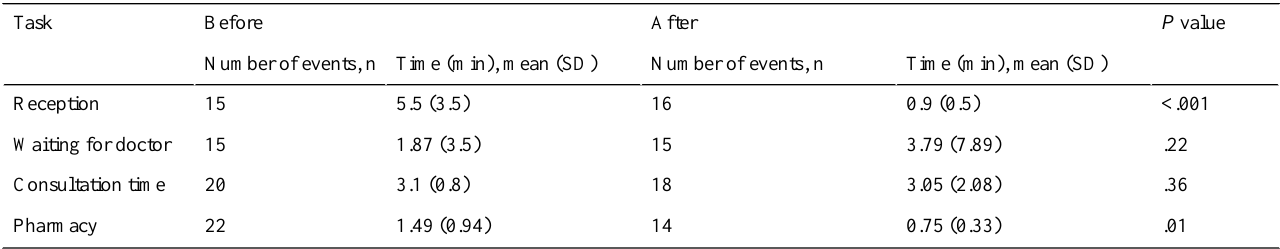
Table 3. The time spent per task at baseline and 12-month follow-up at 1 electronic health record–based primary health care center.